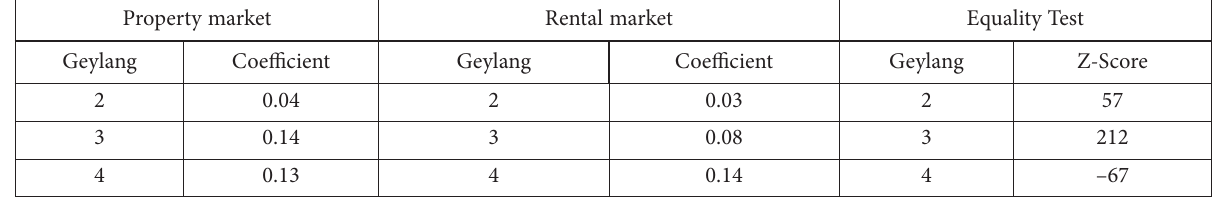
Table 5. The impact of red-light district attributes on both property and rental markets Property market Rental